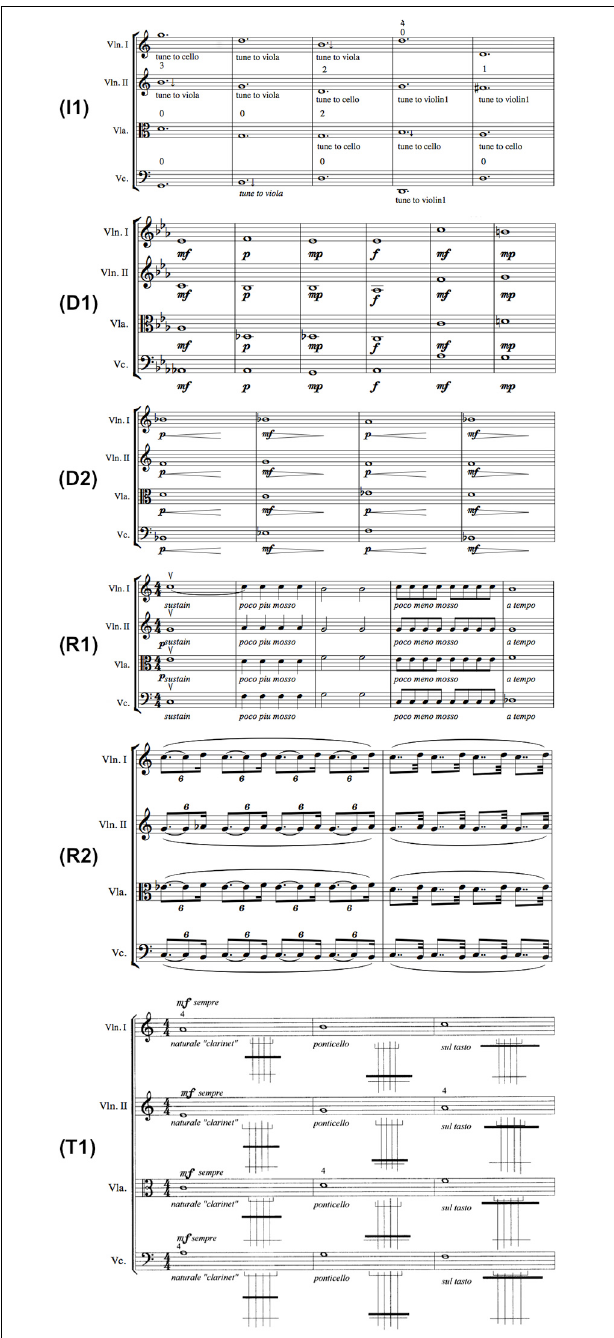
FIGURE 1 | Score excerpts from all exercises used in the experiment. (Legend: I1, Intonation exercise; D1, Dynamics exercise nr.1; D2, Dynamics exercise nr.2; R1, Rhythm exercise nr.1; R2, Rhythm exercise nr.2; T1, Timbre exercise).